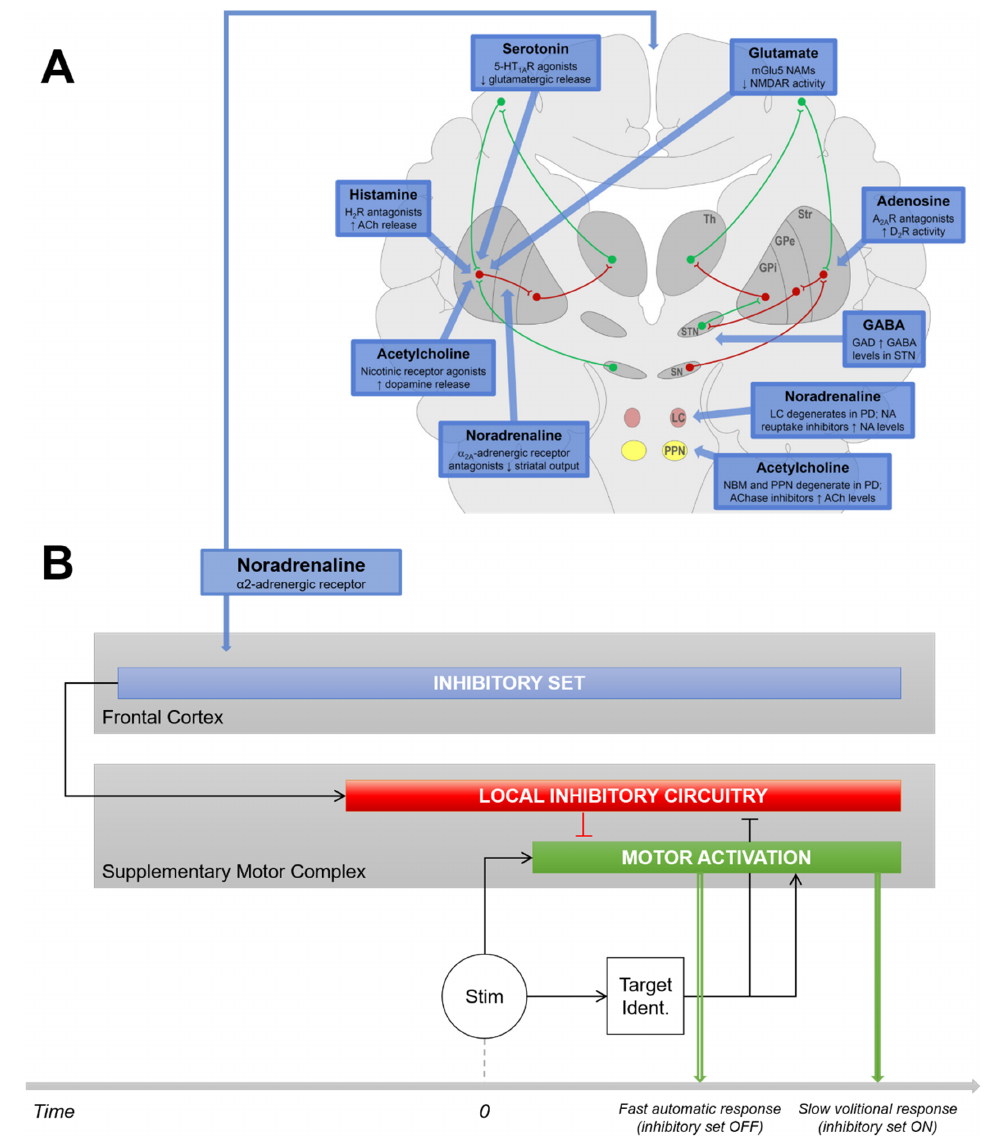
Figure 1. Issues and Hypotheses. ( A ) Nondopaminergic neurotransmitter systems involved in the motor features of PD. Taken from [1] and reproduced with permission. ( B ) We hypothesize that the impairment in initiating movements in PD patients might be related to the NA system. Indeed, the NA system likely plays a substantial role in proactive response inhibition: a cortico–ganglio–thal- amo–cortical function is intended to inhibit movement triggering mechanisms by anticipation to prevent erroneous responses when the context is uncertain. When proactive inhibition is ON, motor responses are delayed with respect to a condition that does not require inhibition (fast automatic